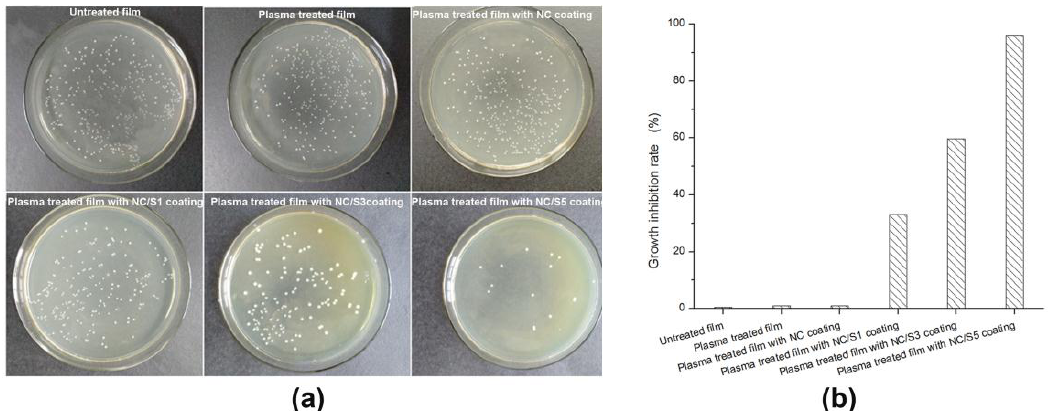
Figure 6. ( a ) Antimicrobial activity assay and ( b ) growth inhibition rate of BOPP/LDPE films against L. monocytogenes.